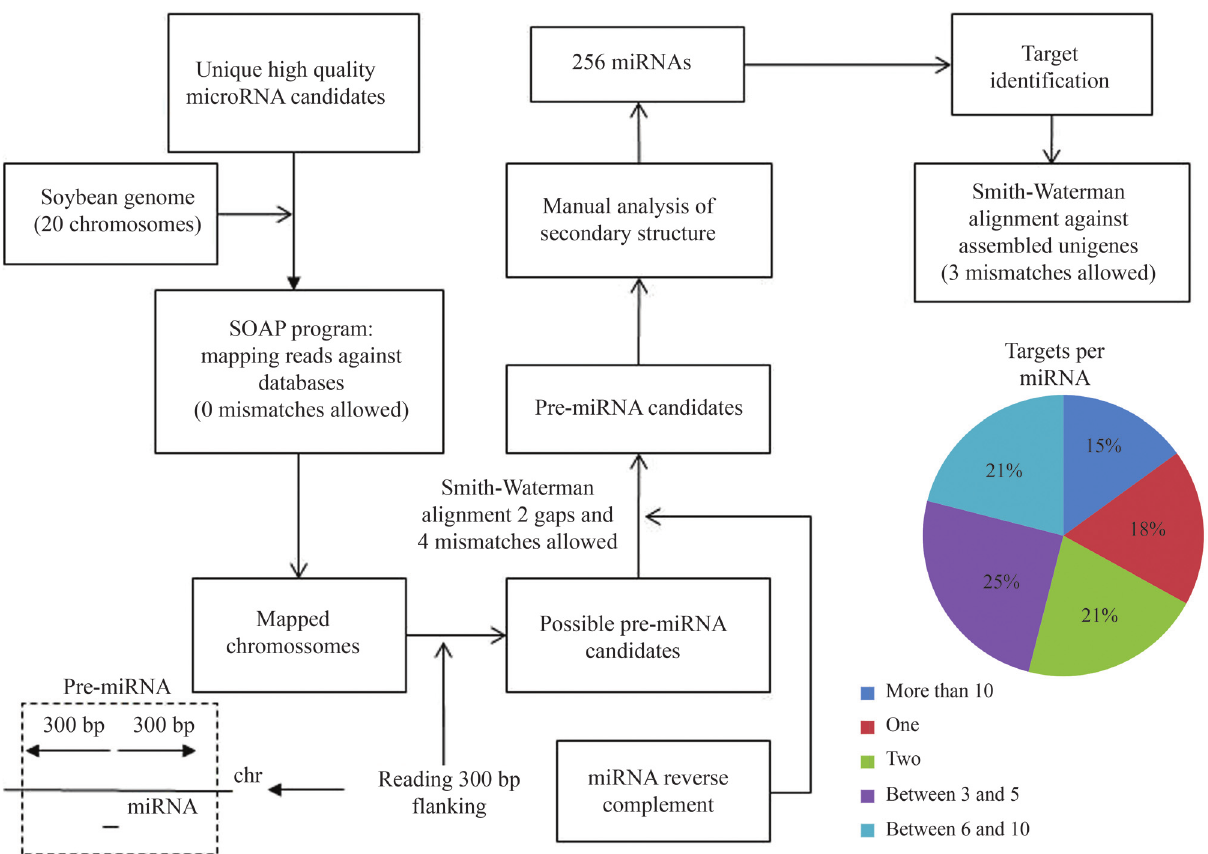
Figure 5 - Pipeline used for microRNA prediction. The microRNA candidates (unique tags, Table 3) were mapped against the soybean genome with the SOAP2 aligner (no mismatches allowed). The genomic region (300 bp upstream and downstream of the alignment position) of the SOAP alignment was mapped with the reverse complement of the original microRNA using the Smith-Waterman algorithm. After manual analysis of the secondary structure, 256 microRNAs were identified. Finally, the Smith-Waterman algorithm (3 mismatches allowed) was used to identify targets in the assembled unigenes (it was possible to identify targets for 169